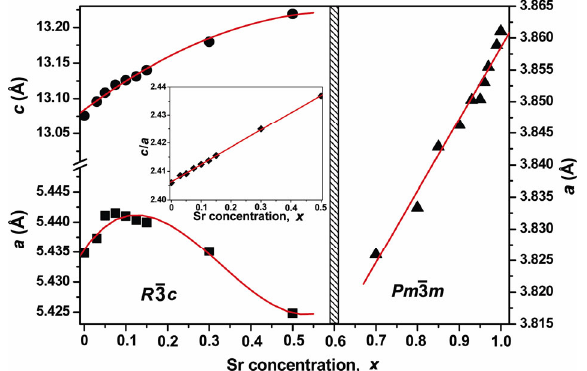
Fig. 5 Variation of the oxygen content (3  ) and the average valence of cobalt as a function of Sr concentration in La 1– x Sr x CoO 3  with 0 ≤ x ≤ 1 at 323